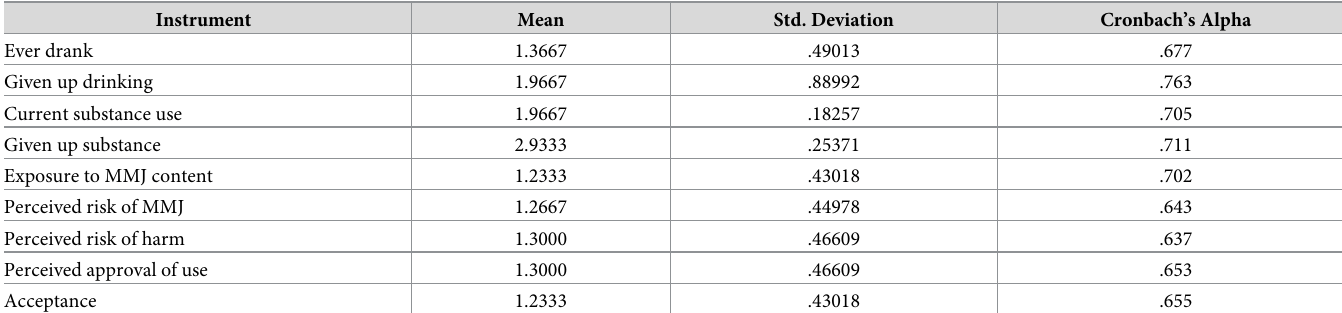
Table 2. Reliability test results of questionnaire items (N =